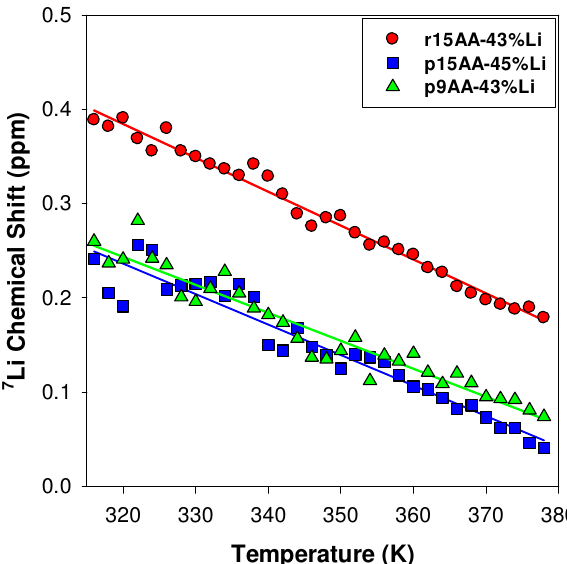
Figure 9. Temperature variation of the 7 Li MAS NMR chemical shifts for different partially Li-neutralized P(E-AA)